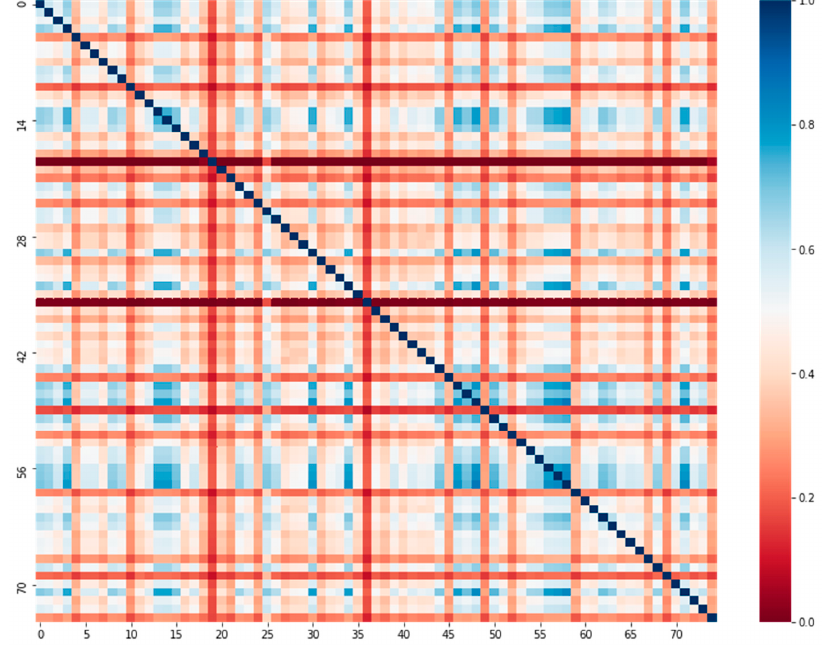
Figure 9. Thermodynamic diagram of group learning interest similarity among disciplines.